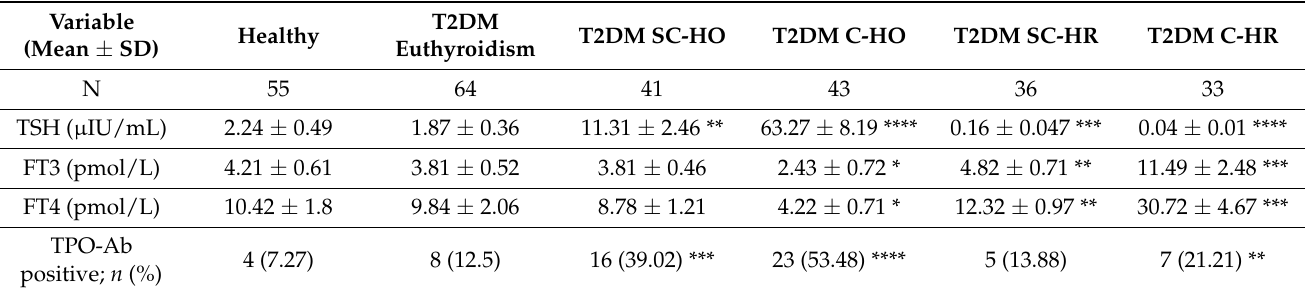
Table 2. Thyroid-hormones profiles of studied population. Data are presented as mean ± standard deviation, SD; T2DM: type 2 diabetes mellitus; SC-HO: subclinical hypothyroidism; C-HO: clinical hypothyroidism; SC-HR: subclinical hyperthyroidism; C-HR: clinical hyperthyroidism; TSH: thyroid- stimulating hormone; FT3: free T3, FT4: free T4; Anti-TPO: anti-thyroid peroxidase antibody; *,